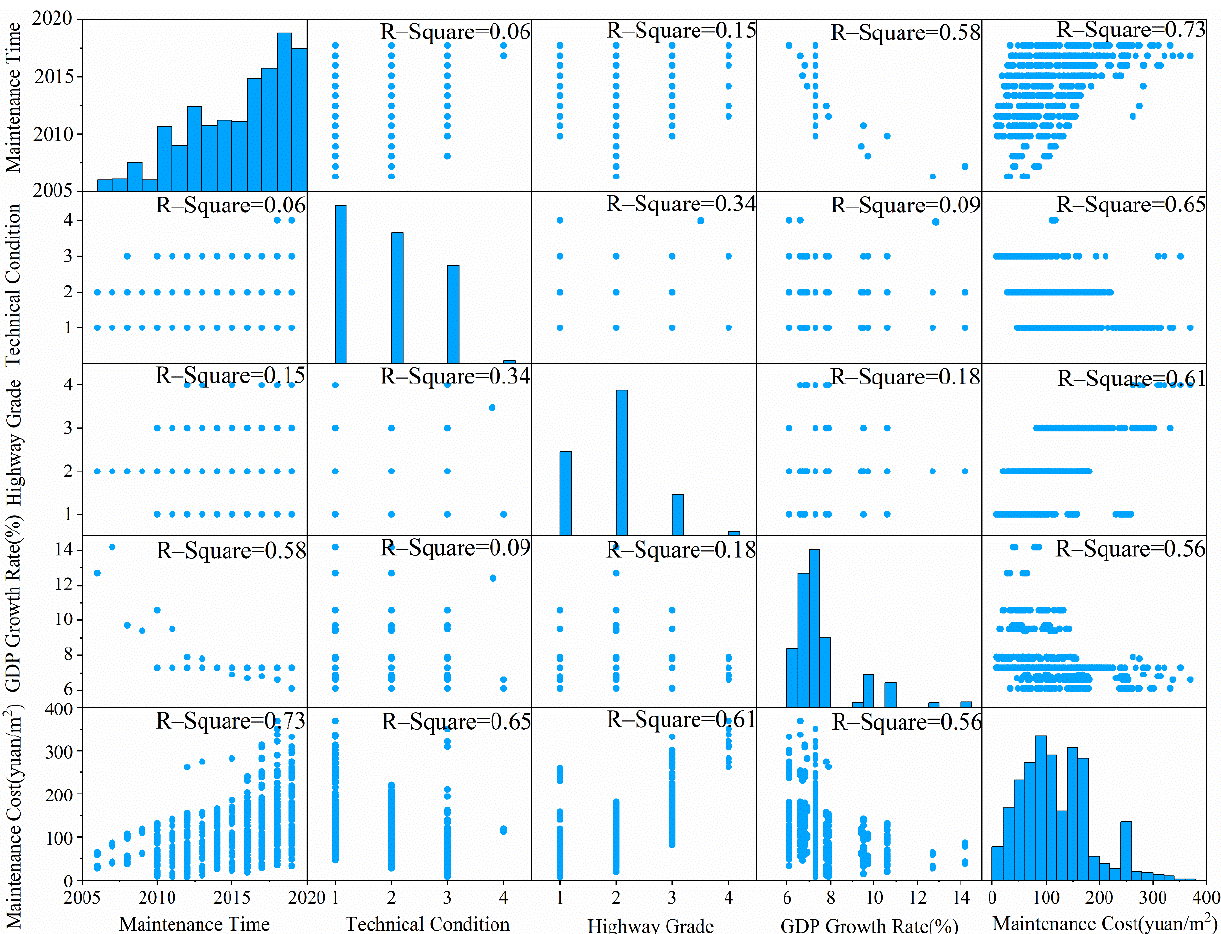
Figure 8. Scatterplot matrix for selected indicators.